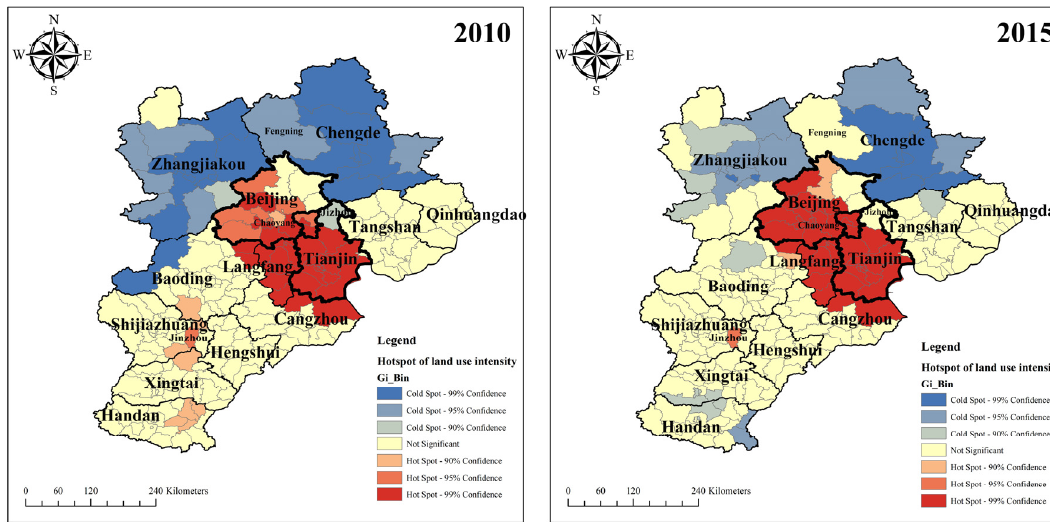
Figure 4. Hotspot pattern of land use intensity in the BTH urban agglomeration in 2010 and